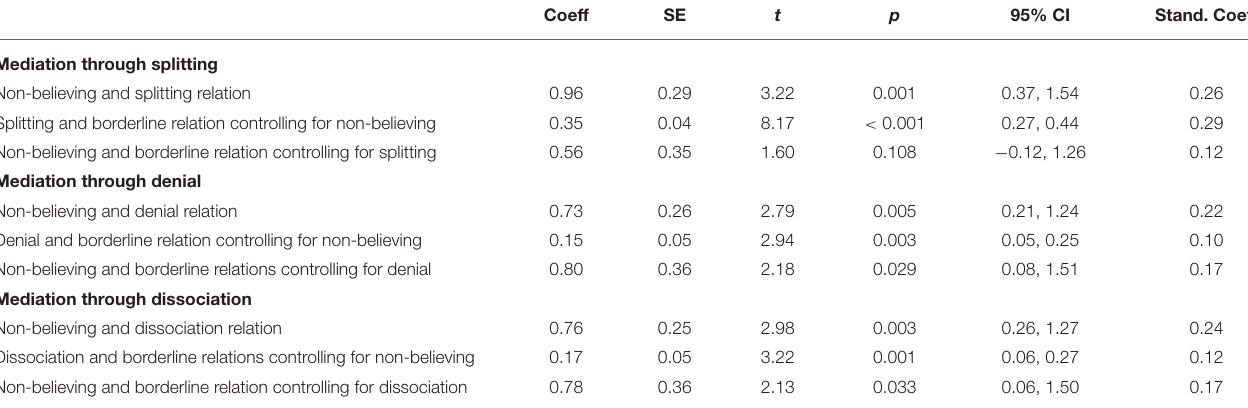
TABLE 2 | Coefficient in models testing relationship between believing vs. non-believing in COVID and borderline symptoms mediated through splitting, denial, and dissociation. Coeff Stand.